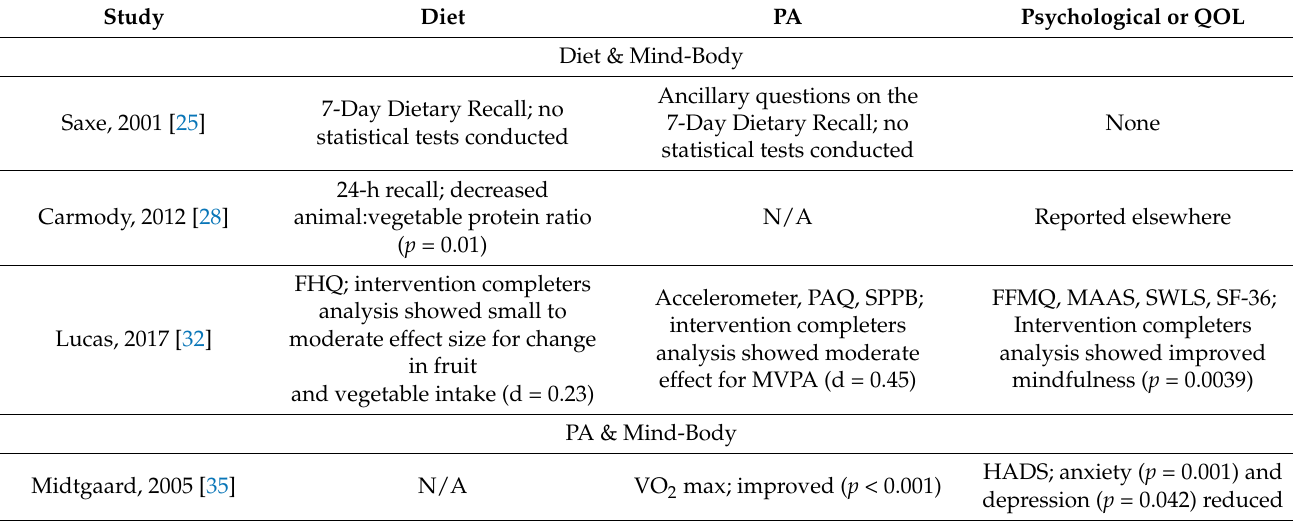
Table 3. Assessment tools and significant findings for outcomes of